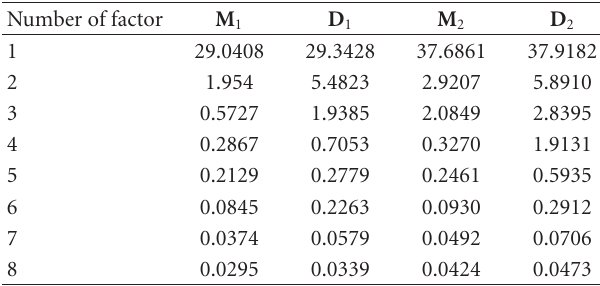
Table 2: Rank analysis of matrices M and D